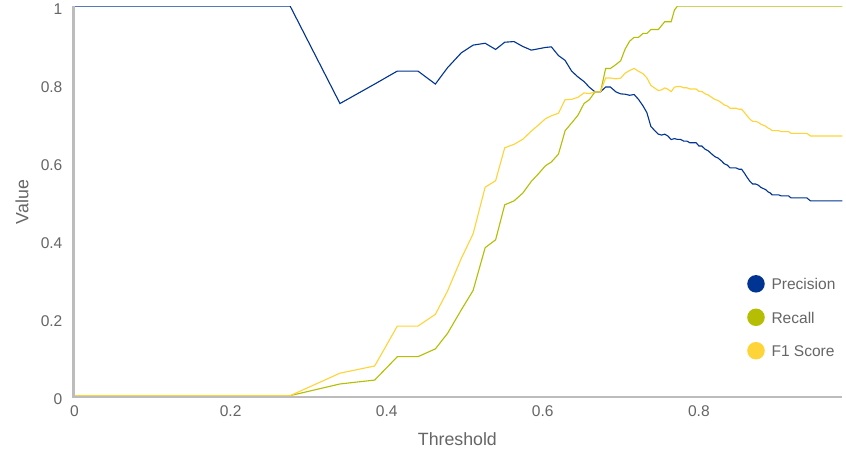
Figure 4. Recall, precision and F1-score vs. threshold when our model is trained with only the selected features from UserA’s dataset, and evaluated on users A and